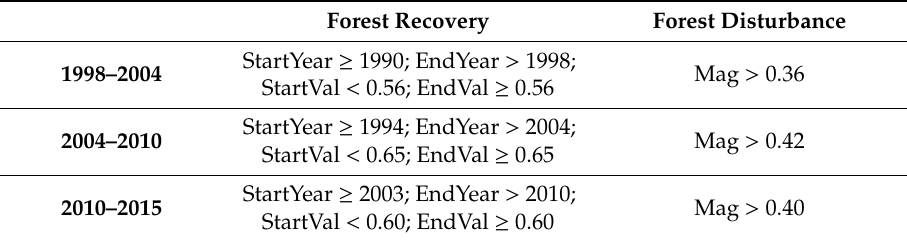
Table 2. Optimal thresholds for forest recovery and disturbance in the di ff erent time